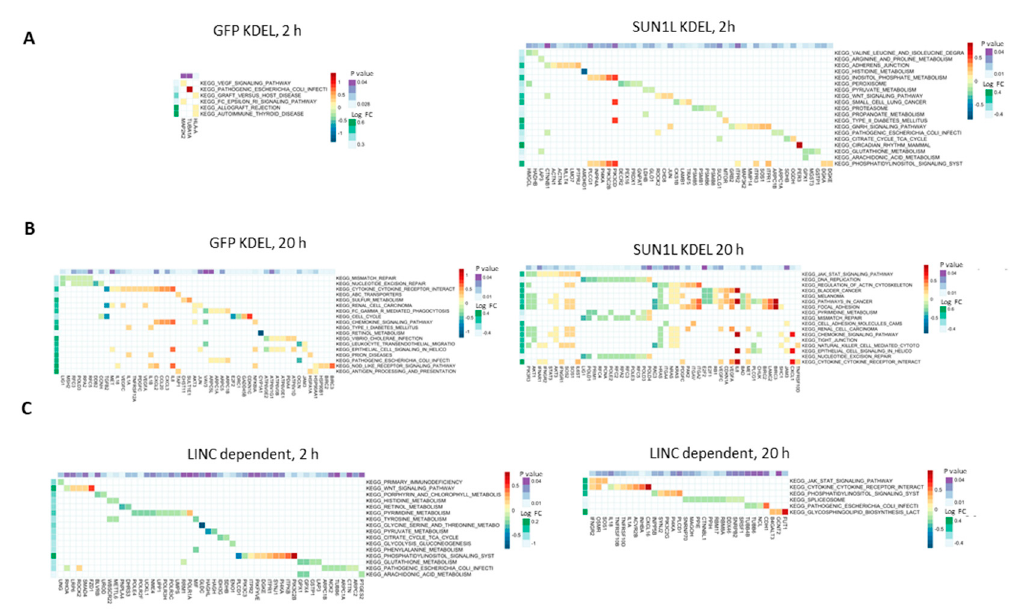
Figure 3. KEGG pathway analysis of differentially expressing genes in SMG vs. 1G after 2 and 20 h. ( A ) Pathways enriched with up-regulated and down-regulated genes in GFP-KDEL cells (left) and SUN1L-KDEL cells (right) after 2h exposure to SMG. ( B ) Up- and down-regulated enriched pathways in GFP-KDEL cells (left) and SUN1L-KDEL cells (right) after 20 h in SMG. ( C ) LINC-dependent up- and down-regulated enriched pathways in SMG after 2 (left) and 20 h(right).